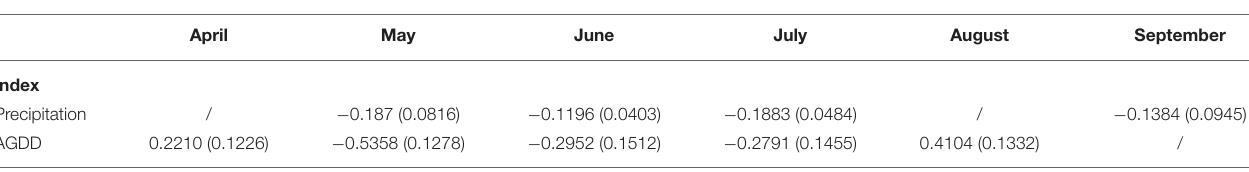
TABLE 3 | The simulation results are based on Model I-optimal.